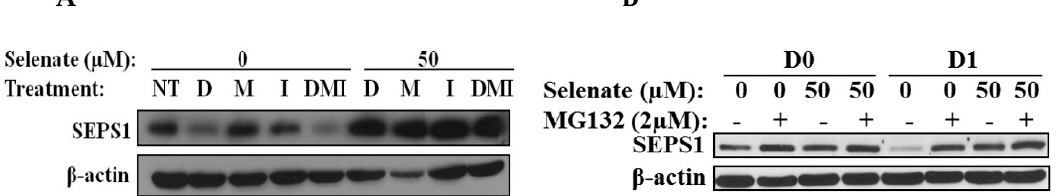
Figure 5. Regulation of SEPS1 by selenate and adipogenic cocktail treatments. ( A ) After 24 h pretreatment of one-day post-confluent 3T3-L1 preadipocytes with 50 µ M selenate, the cells were differentiated in individual components of the adipogenic cocktail, dexamethasone (D), isobutylmethylxanthine (M), and insulin (I), and DMI. Protein samples were collected on Day 2 (D2) and were subjected to immunoblot analysis. ( B ) The samples shown in D0 are one-day post-confluent 3T3-L1 preadipocytes added in the presence or absence of selenate and MG132 for 24 h. The samples shown in D1 include 3T3-L1 preadipocytes treated with DMI with or without MG132 for 24 h, after selenate pretreatment for 24 h. The protein samples at D0 and D1 were subjected to immunoblot assay.